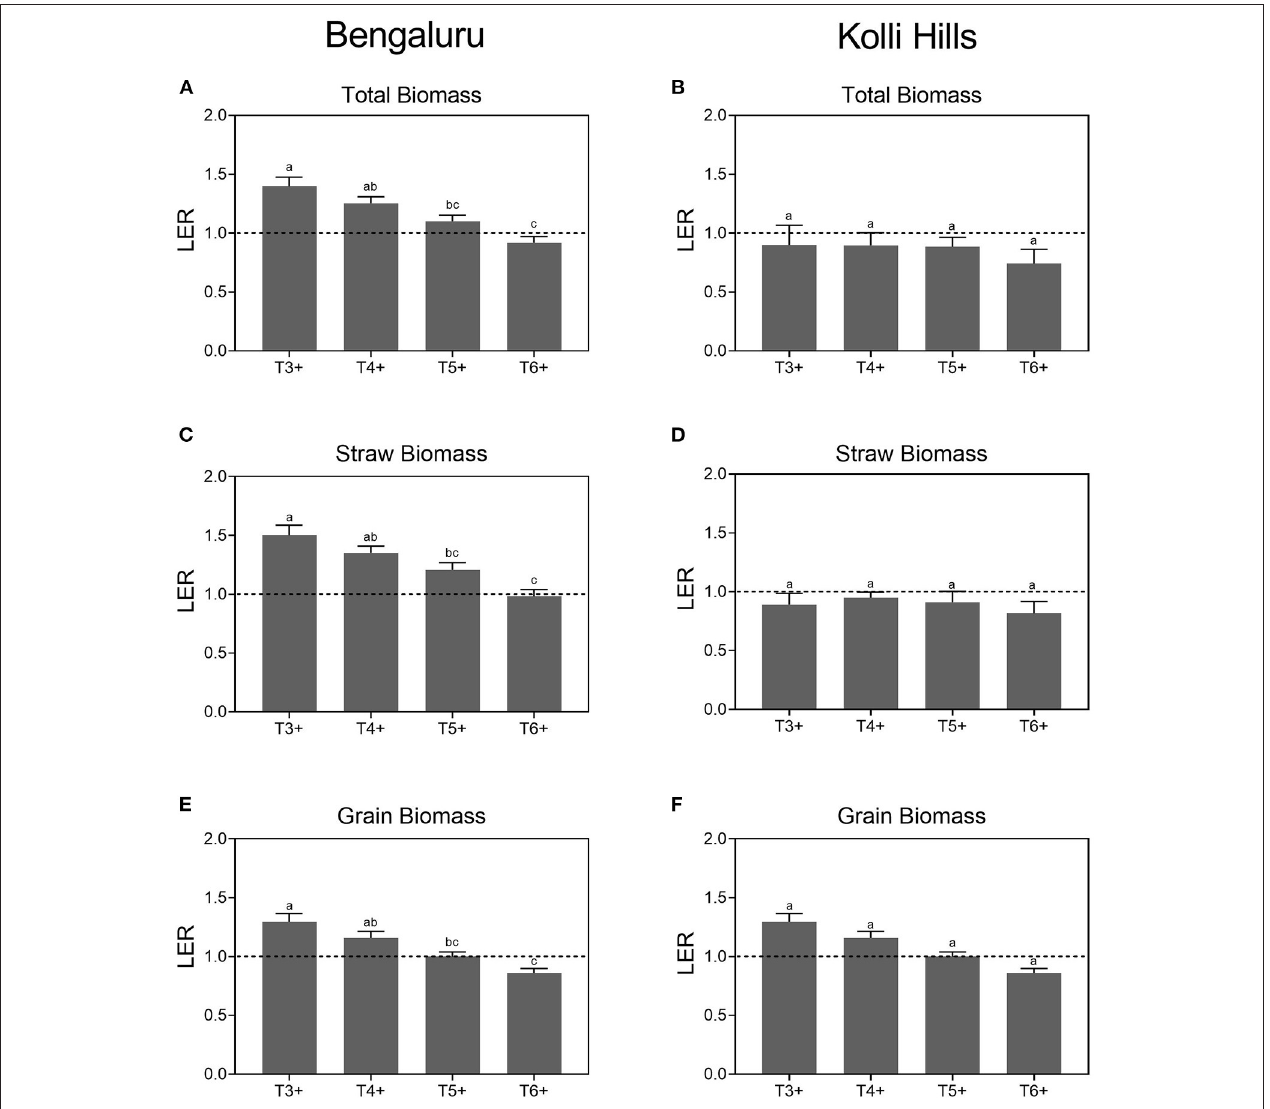
FIGURE 3 | Land equivalent ratio (LER) in different intercropping treatments during 2016/17 at the Bengaluru (A,C,E) and Kolli Hills (B,D,F) sites. Bars represent the average of four replicates with one standard error of mean. Tukey‘s test (one-way ANOVA) was used for multiple comparison, separately for each site, and values with same letters are not significantly different from each other at p >